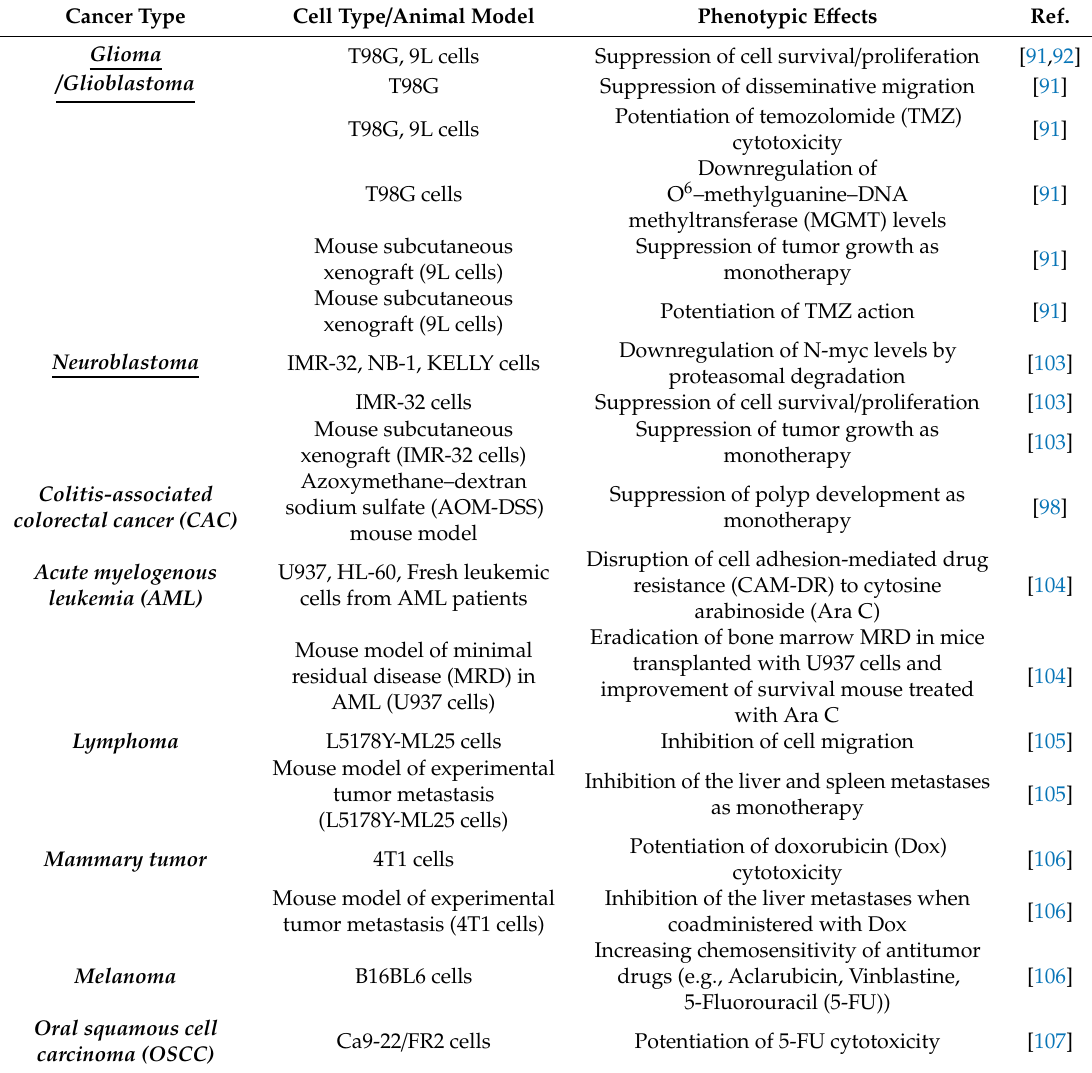
Table 2. Antitumor e ff ects of peptide FNIII14 under in vitro and in vivo